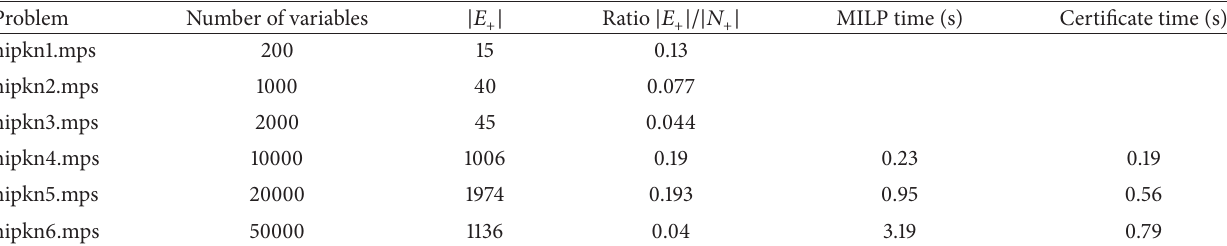
Table 3: Pure integer knapsack problems.